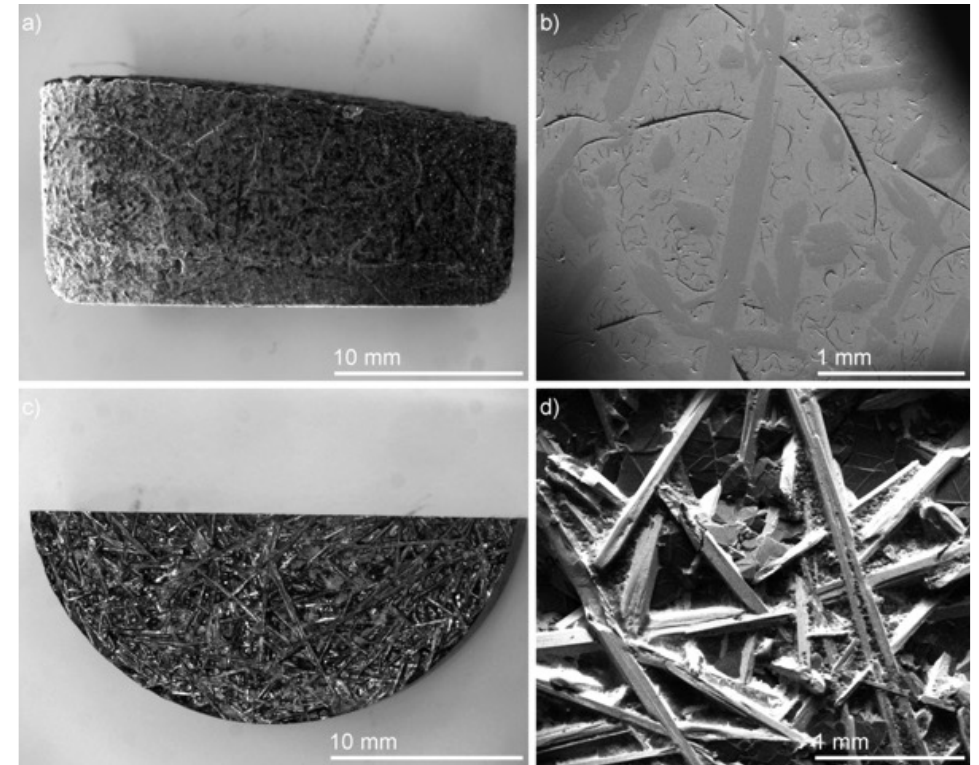
Figure 7. Section views of the as-cast ingot. ( a ) Cross-section optical micrograph and ( b ) corresponding SEM micrograph showing phase morphology. ( c ) Plan-view image of as-cast ingot showing acicular precipitates on the surface and ( d ) corresponding SEM micrograph.